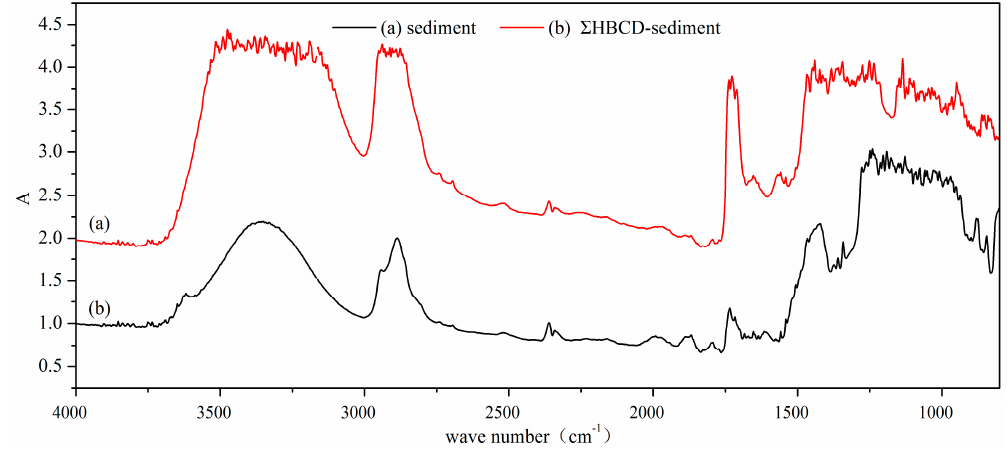
(cid:80) HBCD-sediment.